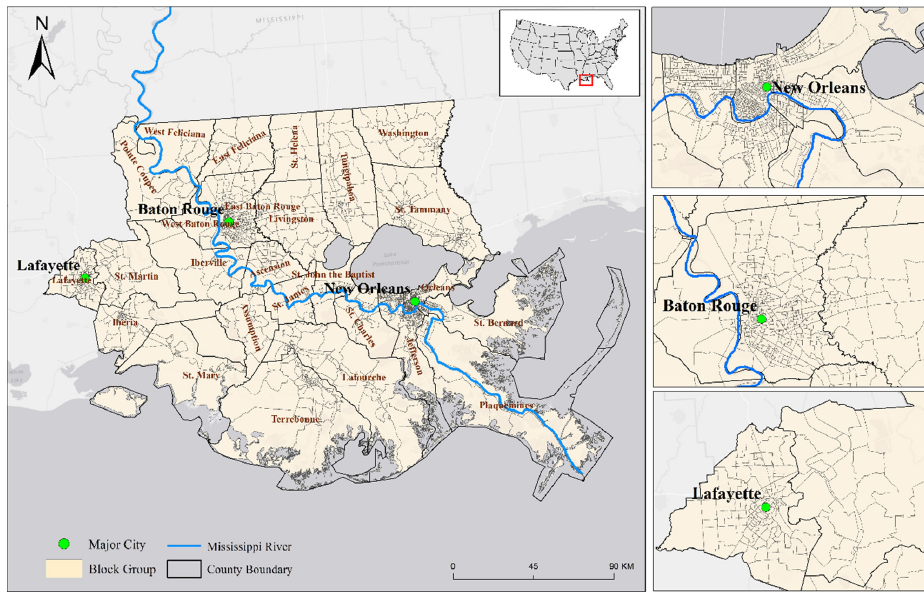
Figure 2. Study area at the block group level.